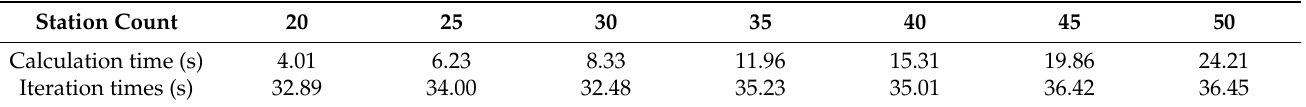
Figure 15. Average selected station count in each generation of the genetic algorithm. Table 11. Weight combination results in upper and lower layers.